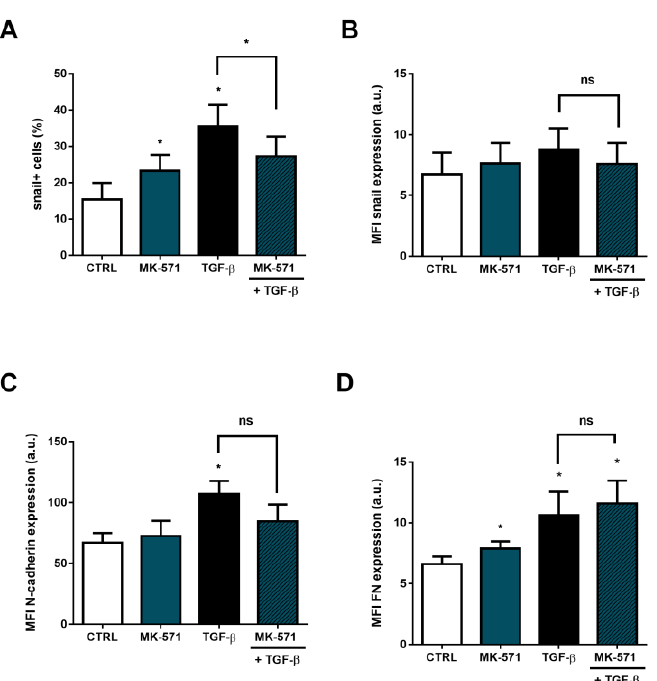
Figure 6. TGF- β -induced epithelial-mesenchymal transition (EMT) increases ABCC1 expression. A549 cells (1 × 10 5 cells/mL) were incubated with 5 ng/mL TGF- β for EMT induction. After 48 h, the cells were stained with anti-ABCC1 antibody and ( A ) percentage of positive cells and ( B ) protein expression were evaluated by flow cytometry. Expression is represented by median fluorescence intensities (MFI). Bars represent mean + SEM, and the values of significance were represented by (*) for p < 0.05 from four independent experiments.